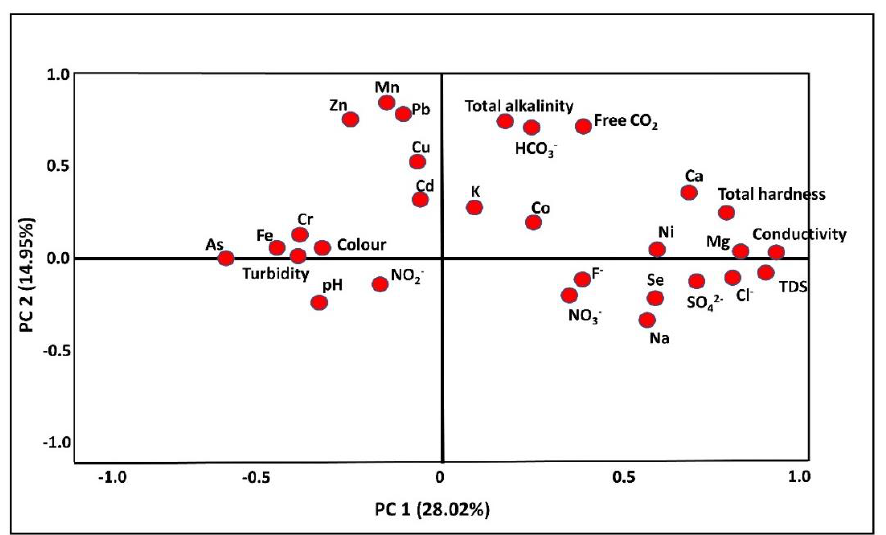
Figure 8. Bi-plots for PC1 and PC2 showing the strength of variables by their closeness and location in the